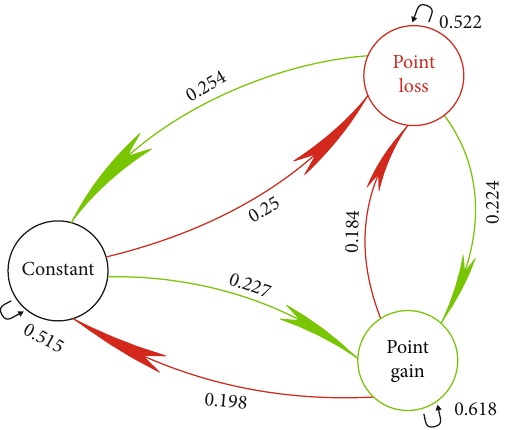
Figure 8: GCB Bank Plc equity transition matrix and